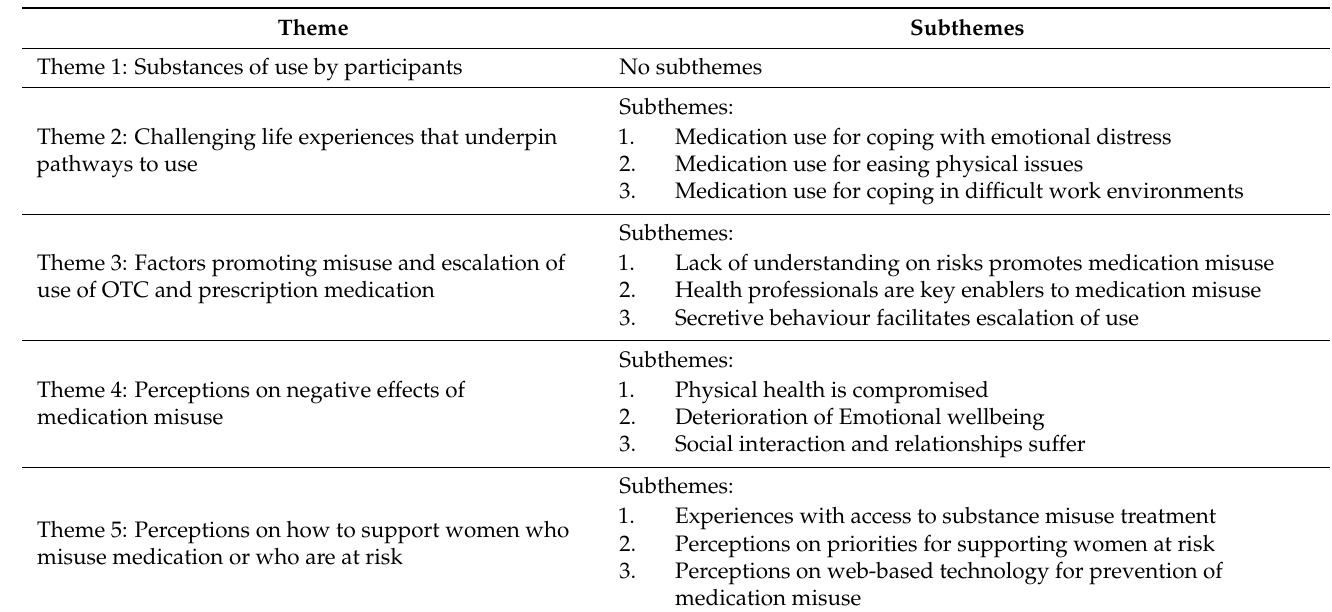
Table 2. Experiences and perceptions of South African women on use of prescription or over-the- counter medication.